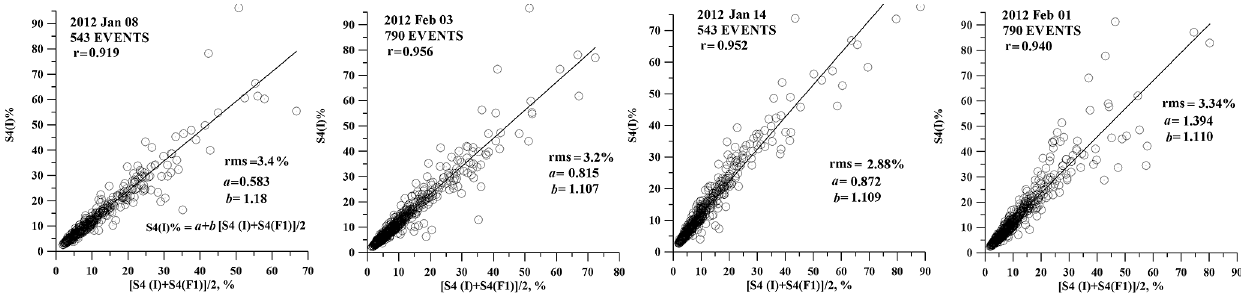
Figure 8. Correlation of indices S4(I) and [S4(F1) + S4(I) ] /